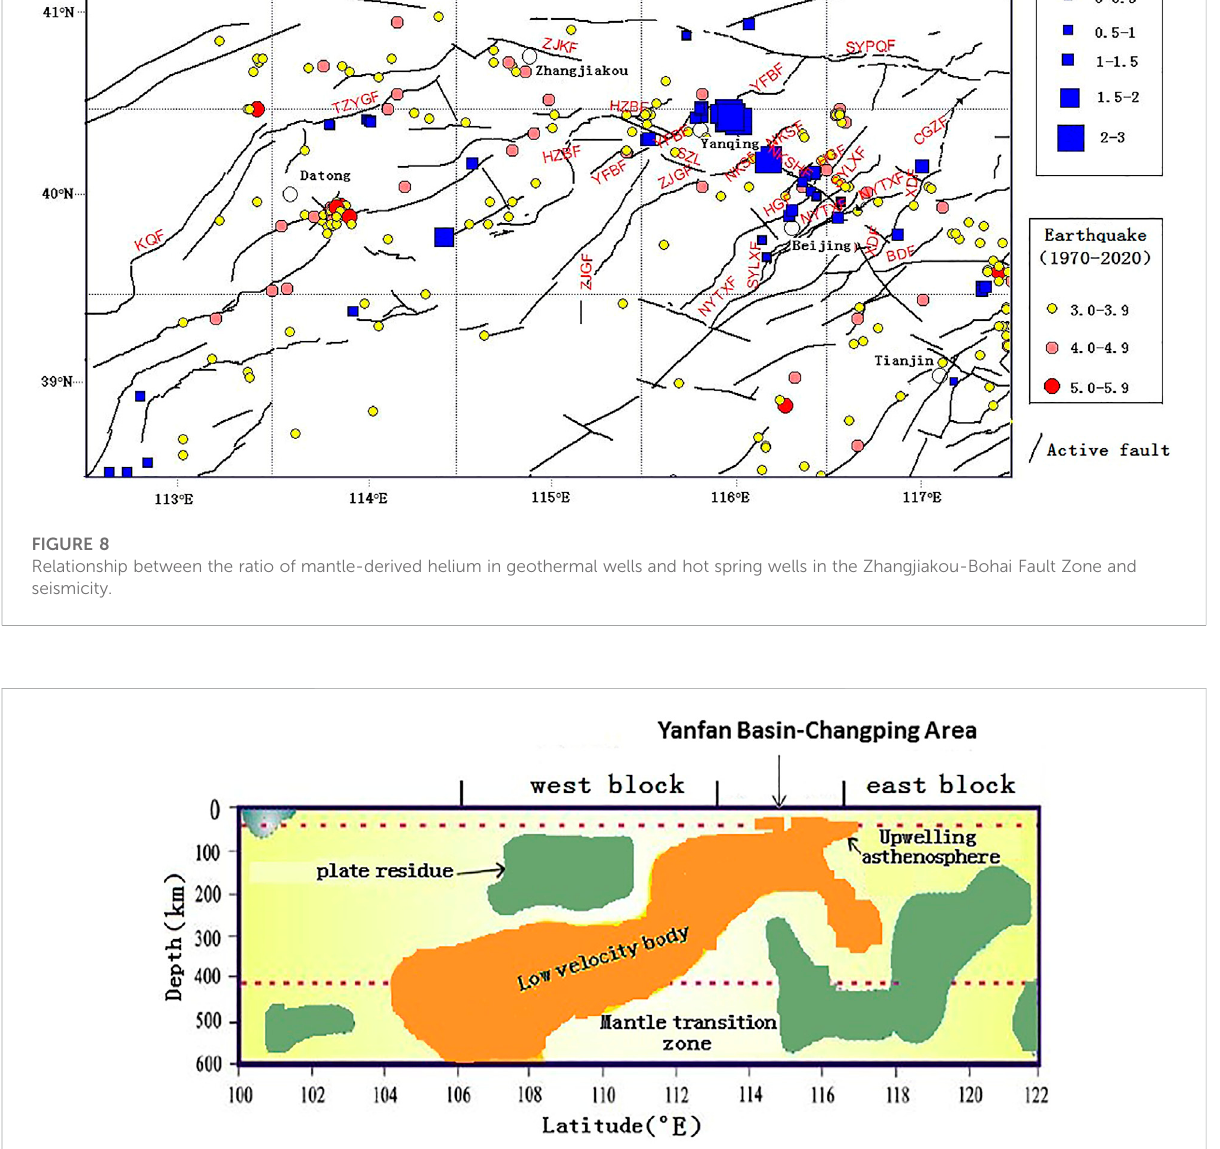
FIGURE 9 Mantle structure model of the North China Craton at 40 ° N latitude (base map after Santosh et al.,